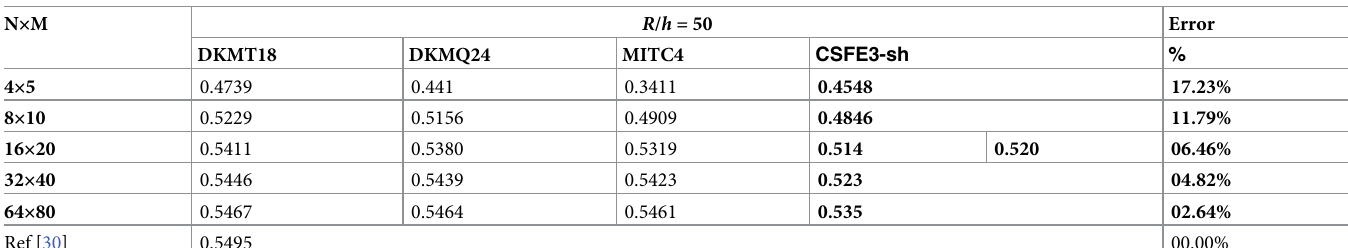
Table 3. Convergence of deflection W